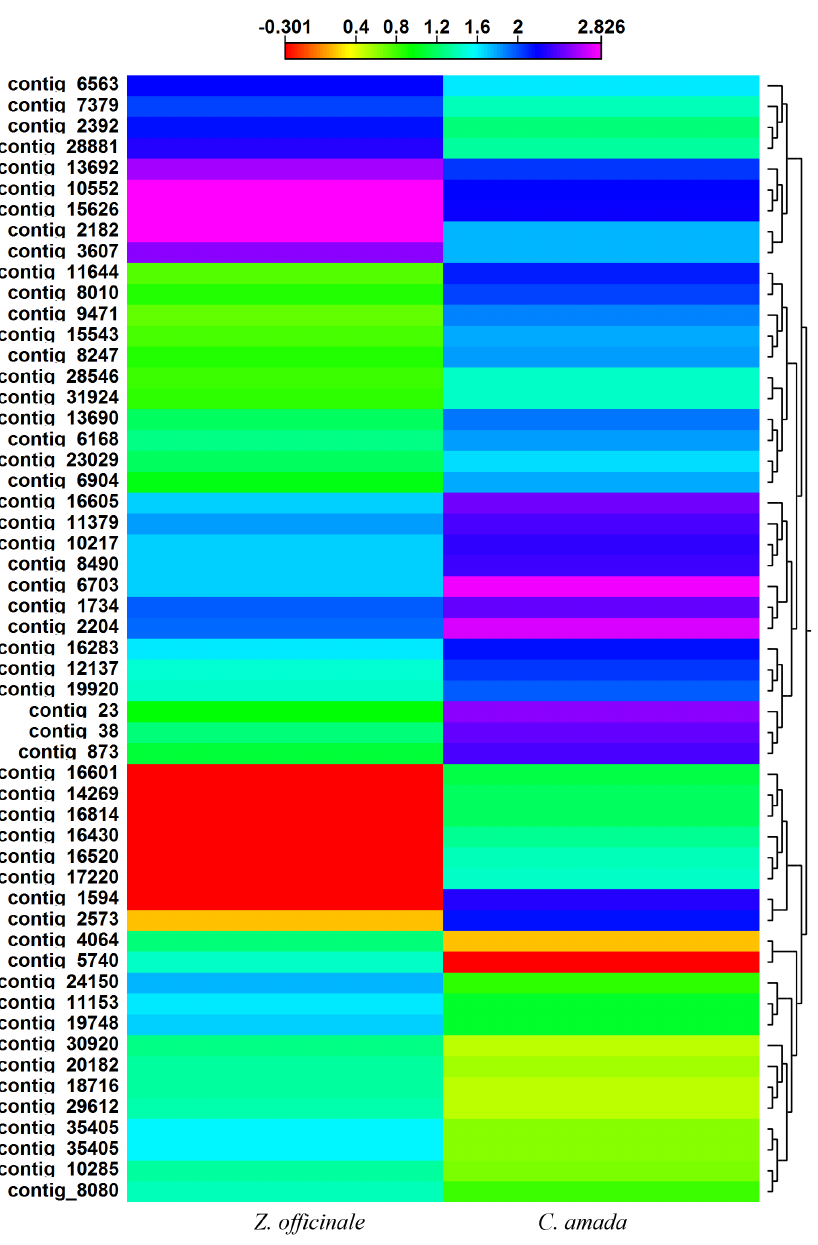
Figure 7. Divergence in the expression levels of transcription factors (TF) transcripts between C. amada and Z. officinale. Heat map and clustering analysis of the transcripts of genes encoding TFs are shown. Higher expression of TFs occurs in C. amada . The high expression levels are depicted in purple and low expression in red. Clustering and heat map was drawn with CLC Genomics Workbench based on an Euclidean distance matrix, after normalization of expression